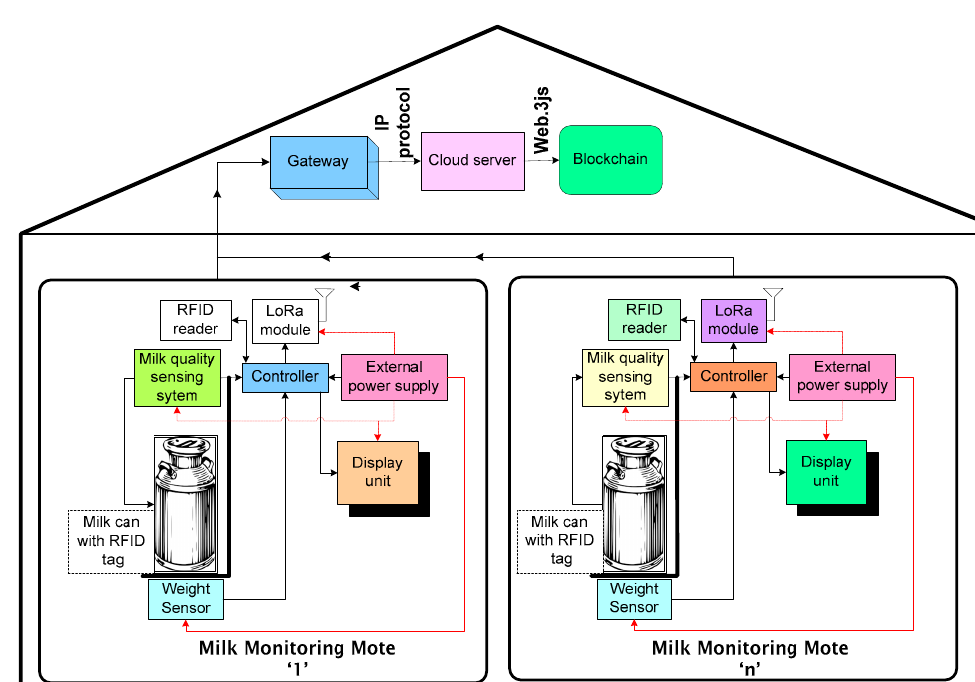
Figure 7. IoT enabled system for monitoring milk quality and supply chain.